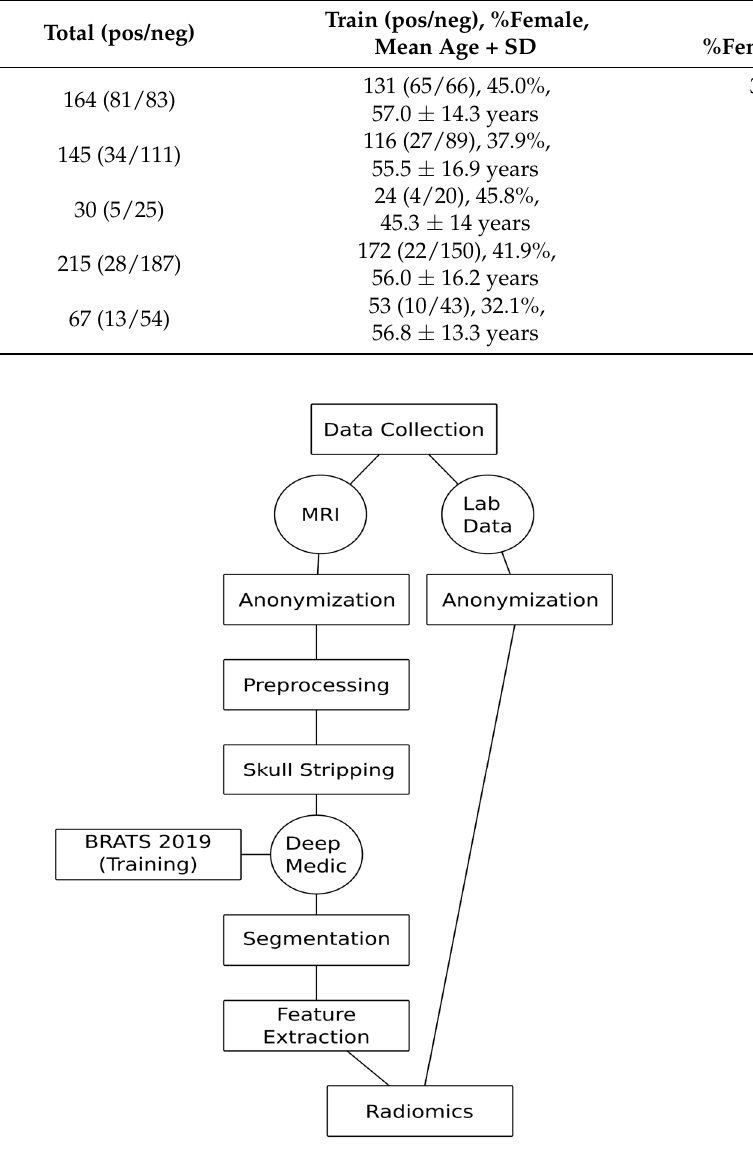
Figure 2. Automated virtual biopsy workflow.